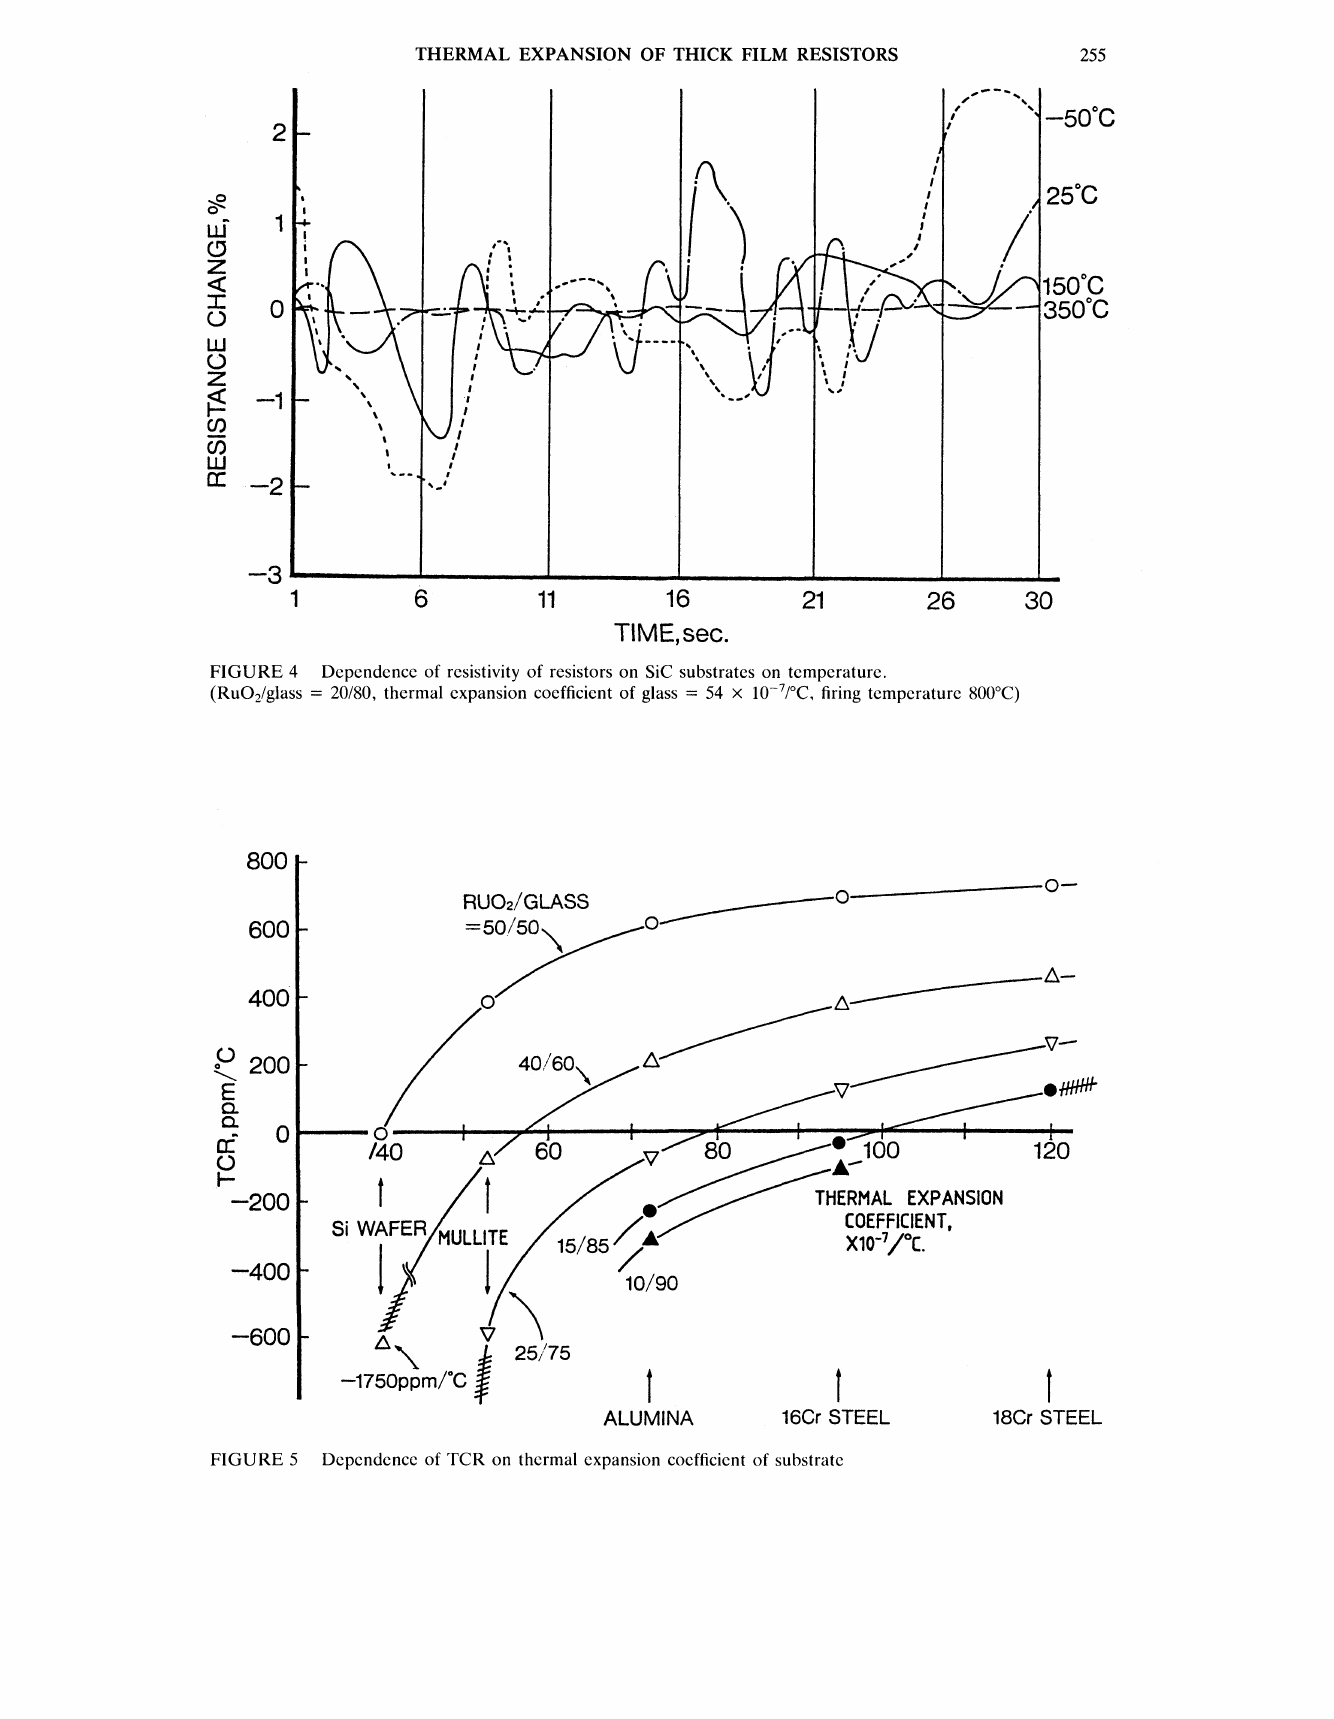
FIGURE 5 Dependence of TCR on thermal expansion coefficient of